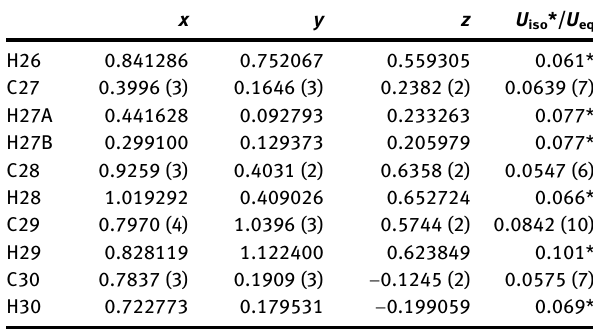
Table  : Fractional atomic coordinates and isotropic or equivalent isotropic displacement parameters (Å 